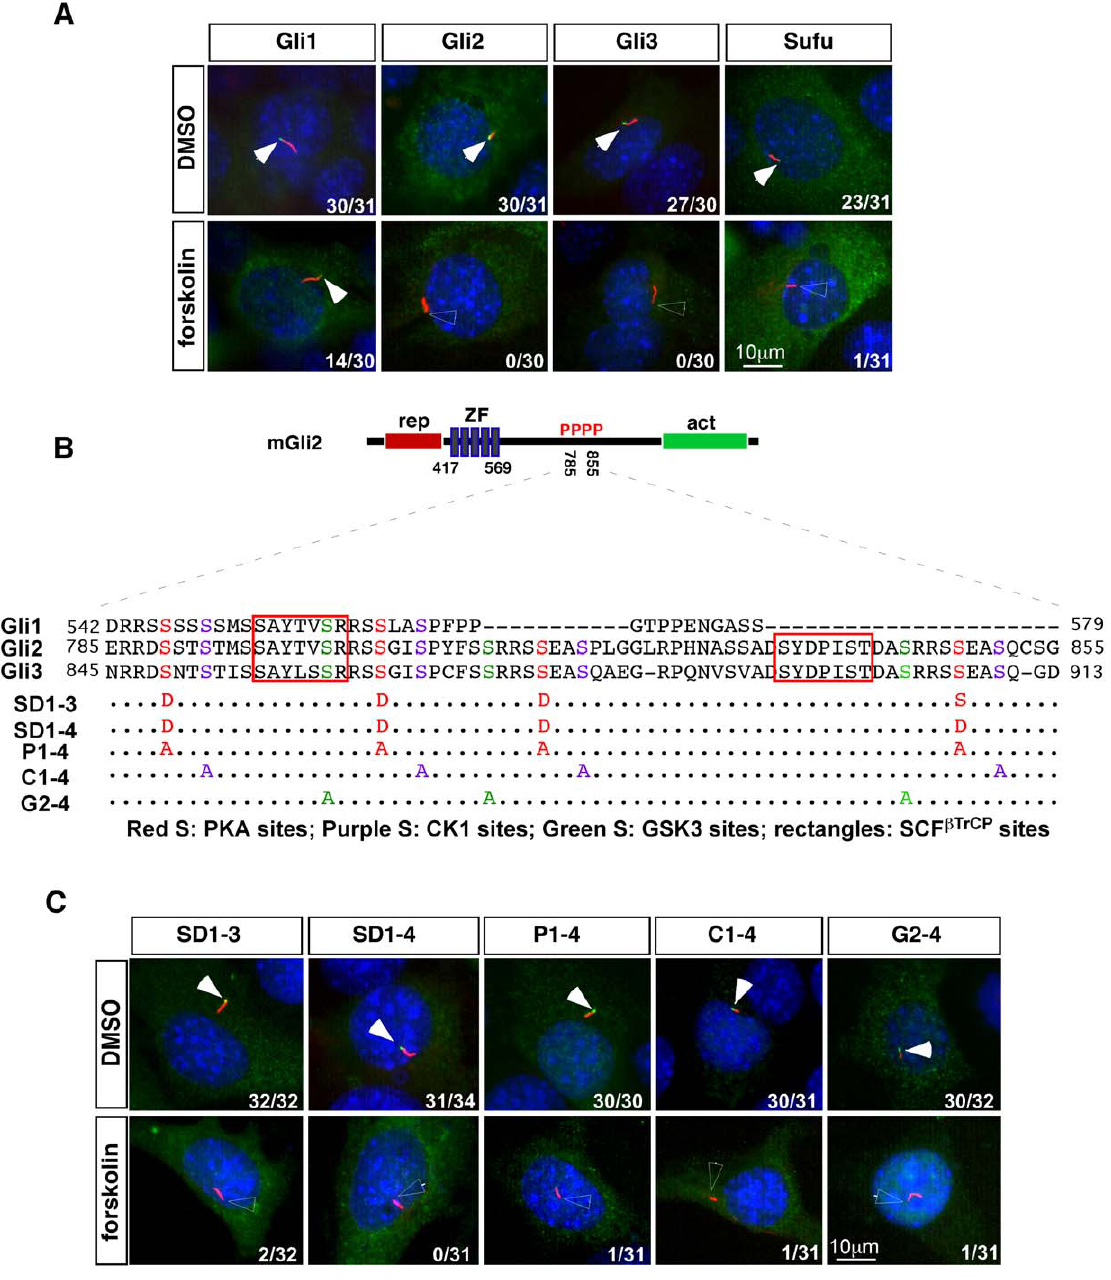
Figure 4. Protein kinase A negatively regulates the ciliary localization of Gli and Sufu proteins. (A) The ciliary localization of GFP-tagged Gli1, Gli2, Gli3 and Sufu are inhibited by a treatment (4 hours for Gli proteins and 18 hours for Sufu) with 40 m M forskolin, but not the solvent (DMSO) alone. The reduction of Gli1 ciliary localization is relatively moderate compared to Gli2 and Gli3 and weak ciliary signal is shown in the image. (B) Peptide sequence of mouse Gli2 protein in the region of residues 785–855,as well as its alignmentwith Gli1 andGli3. In SD1-3 andSD1-4,thefirstthree or allfour Serine residues targeted by PKA are mutated to Aspartic acids. In P1-4, C1-4 and G2-4, Serine-to-Alanine mutations are created for all PKA, CK1 and GSK3 target sites, respectively. (C) Variants of GFP-Gli2 with mutations in their kinase sites are localized to the cilia in the presence of the solvent (DMSO), but not 40 m M forskolin (FSK) (4 hours of treatment for SD1-3, SD1-4 andP1-4; 18 hours of treatmentforC1-4 andG2-4). Immunofluorescent images of MEFs transfected with GFP-tagged Gli proteins areshown.Cilia arelabeled with acetylated tubulin andnucleiarestained with DAPI. Filled arrowheads indicate GFP signal at the tips of the cilia, unfilled arrowheads indicate the tips of cilia without GFP signal. Numbers at the lower-right corners of each image indicate numbers of cells with ciliary localization of GFP-tagged proteins over total numbers of transfected cells. doi:10.1371/journal.pone.0015900.g004 The dependence of Sufu ciliary localization on Gli proteins To confirm a direct role for Gli proteins in ciliary localization of suggests that PKA activation may similarly inhibit Sufu ciliary Sufu, we expressed either GFP-Gli1 or GFP-Gli2 in Gli mutant cells. localization. Indeed, in the presence of forskolin, the ciliary We found that the expression of either gene efficiently restores the localization of GFP-Sufu is inhibited (Fig. 4A, Table 2; n= 1/31). ciliary localization of endogenous Sufu in Gli mutant cells (Fig. 6A,